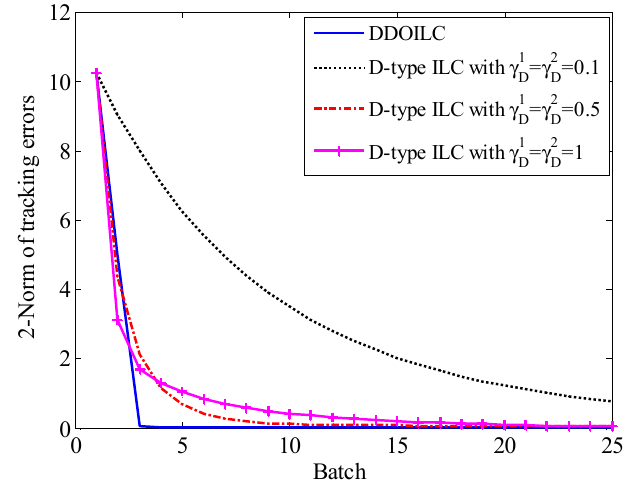
Figure 6. Comparison of the DDOILC with the D-type ILC.